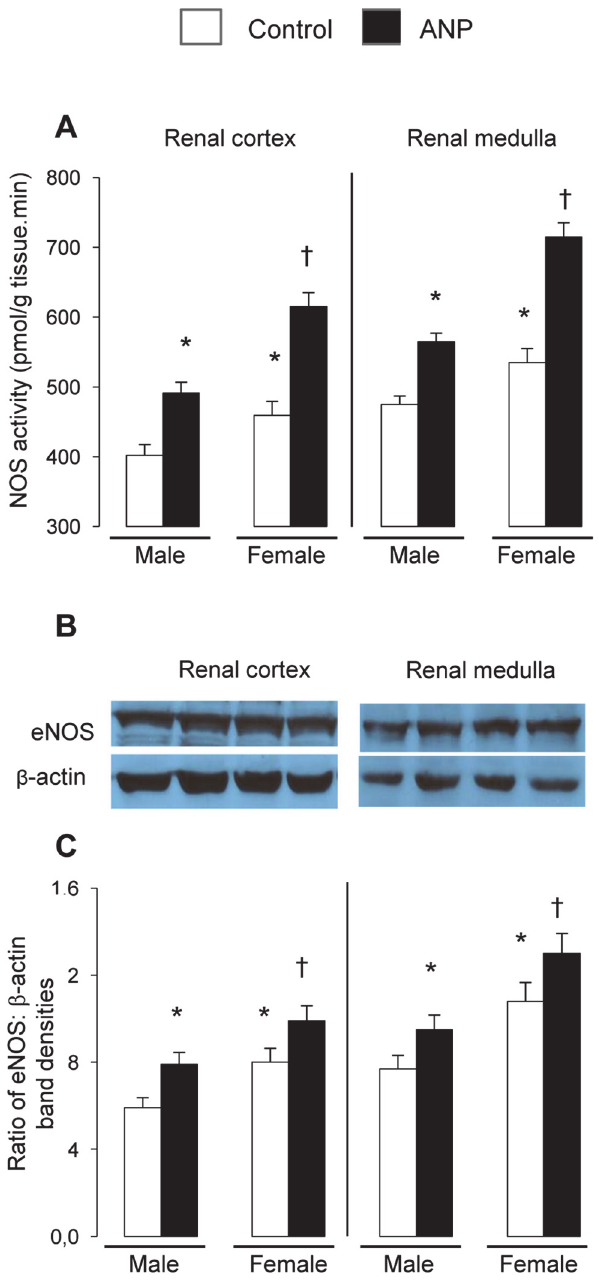
Fig 1. Effects of ANP treatment on renal NOS. (A) Nitric oxide synthase (NOS) activity; (B) Representative blots of eNOS and β -actin; (C) Quantification of eNOS bands. All experiments were performed in triplicate. β - actin was used as a loading control and data are normalized to actin expression. White spaces demarcate noncontiguous gel lanes. Data are mean ± SEM (n = 12). * p < 0.01 vs Control male, † p < 0.01 vs Control